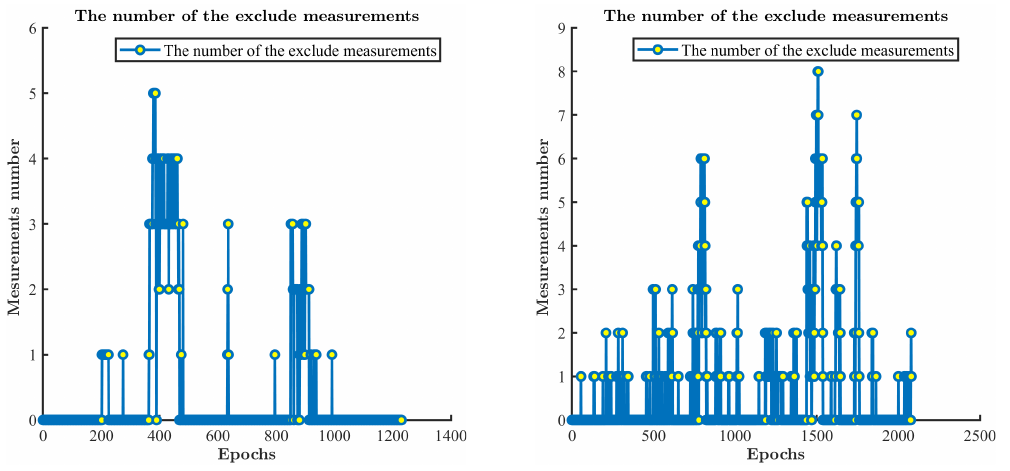
Figure 9. The number of the excluded